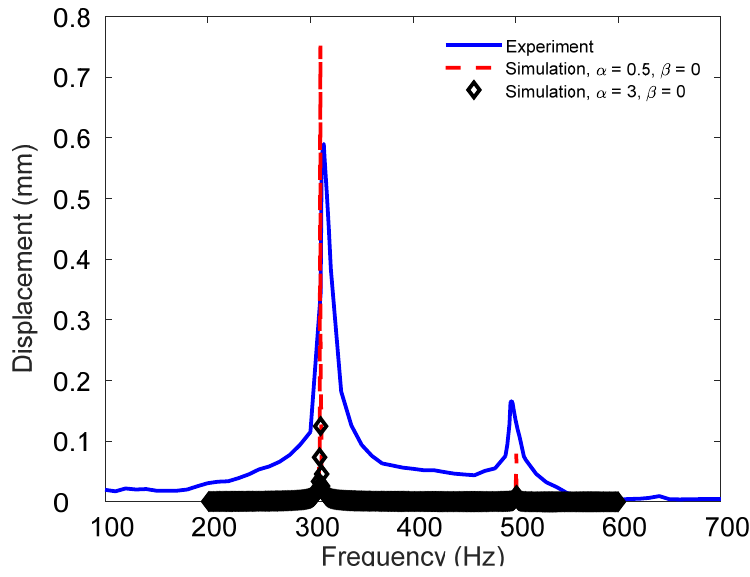
Figure 11. Experimental frequency response function of the Bézier plate with a frequency ratio of 1.61.